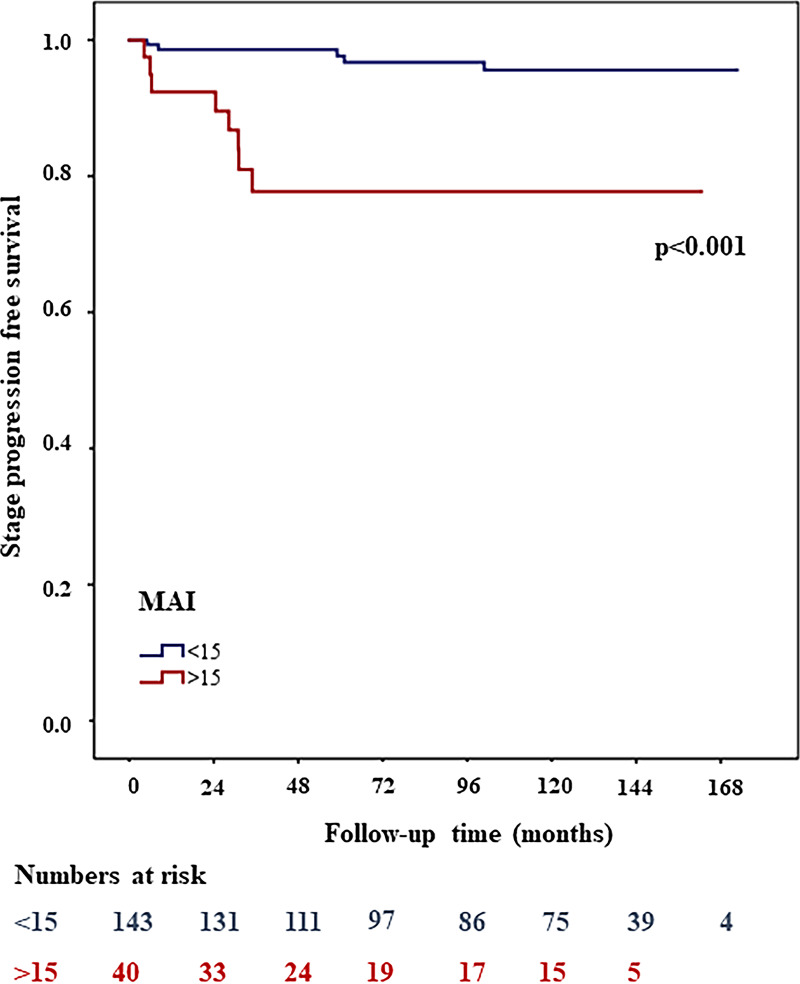
The combination of MAI and CD25+ stratifies patients into three groups.Patients with both low MAI and CD25+ values showed a better outcome than those with high amount of MAI and/or CD25+.